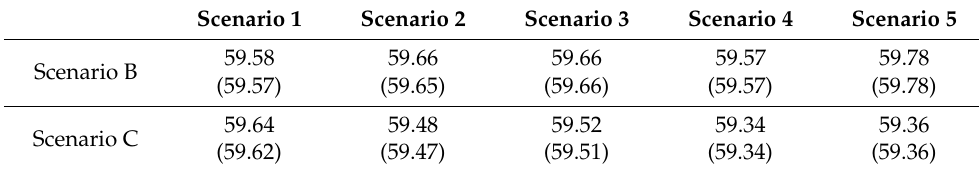
Table 16. Lowest frequency applying optimal parameters (three-phase short circuit) (Hz): before.